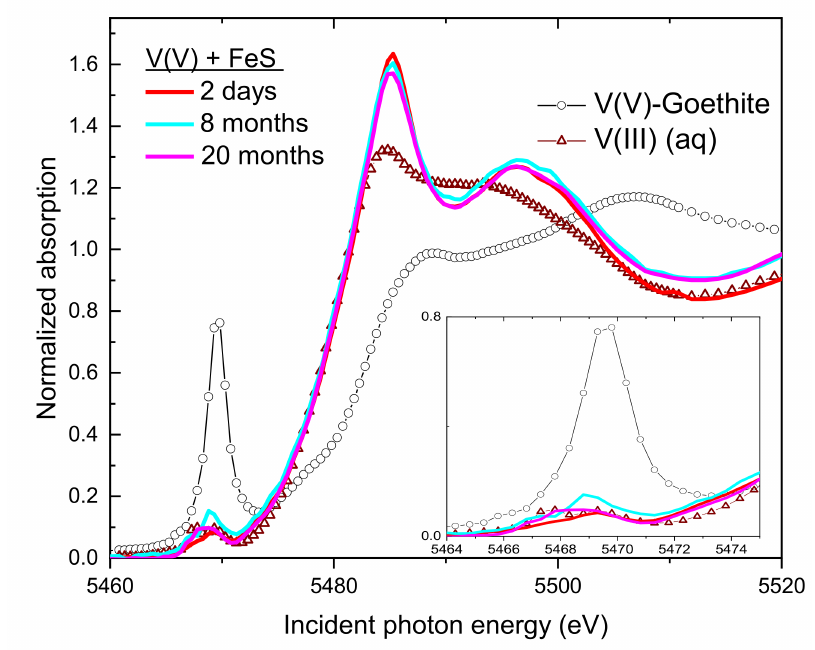
Figure 3. The V K-edge XANES spectra of the solids in the mackinawite system over time compared to representative standards V(V) sorbed to goethite and aqueous V(III). Inset shows details in the pre-edge